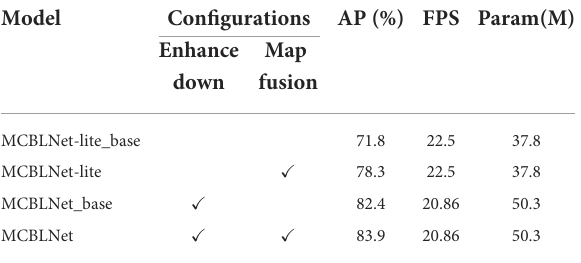
TABLE 3 Ablation experiments on the CBL